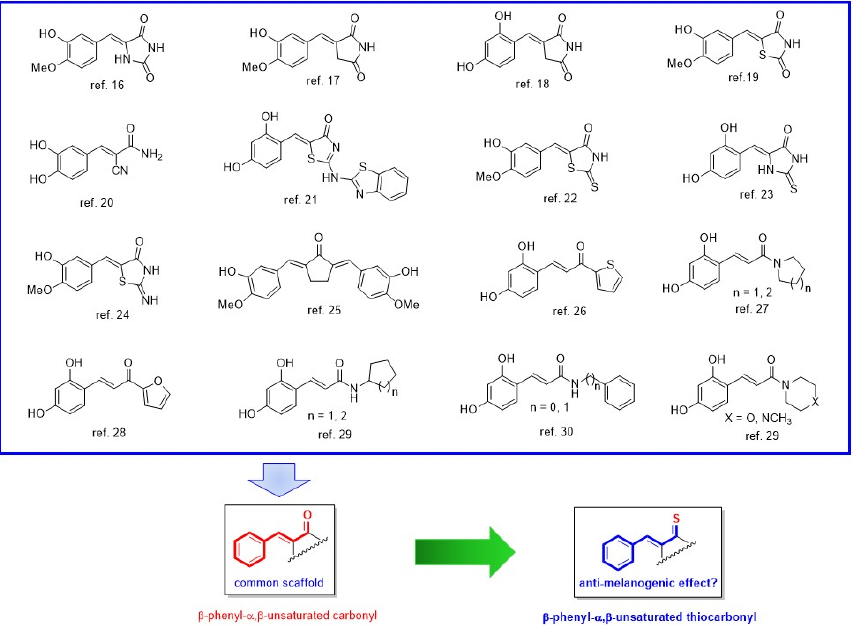
Figure 1. Potent tyrosinase inhibitors with a β -phenyl- α , β -unsaturated carbonyl (PUSC) scaffold and a diagram showing the relationship between the PUSC and PUSTC scaffolds.